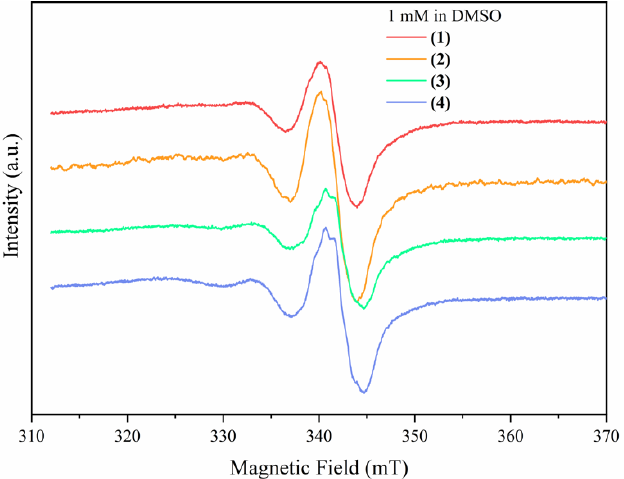
Figure 5 . Powder EPR spectra of the complexes (( 1 )-( a ), ( 2 )-( b ), ( 3 )-( c ), and ( 4 )-( d )). Solution EPR Spectroscopy